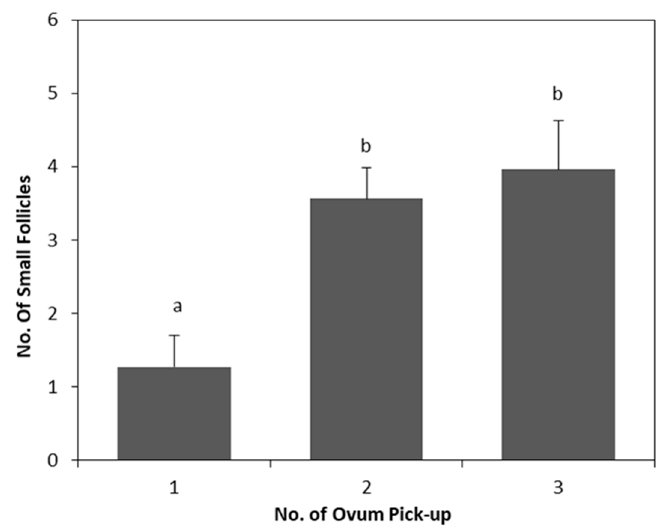
Figure 2. Effect of serial LOPU on number of small follicles from hormonal stimulated goats. a,b: bars with different letters between No. of LOPU differ ( p < 0.05). Values are expressed as mean ± standard error of the mean.